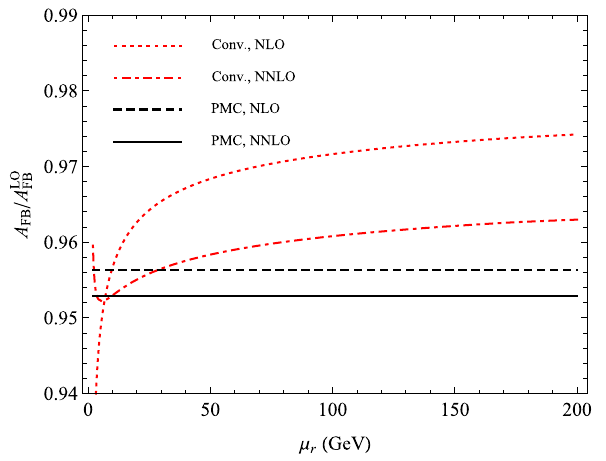
Fig. 1 The QCD correction factors A FB / A LO versus the renormaliza- FB tion scale μ r for the b quark forward–backward asymmetry with the thrust axis definition using the conventional (Conv.) and PMC scale set- tings, where the dashed and solid lines stand for the PMC predictions up to the NLO and NNLO level, respectively; the dotted and dot-dashed lines are the corresponding results for conventional scale settings. The renormalization scale μ r is changed in a wide range of μ r ∈ [2 GeV, 200